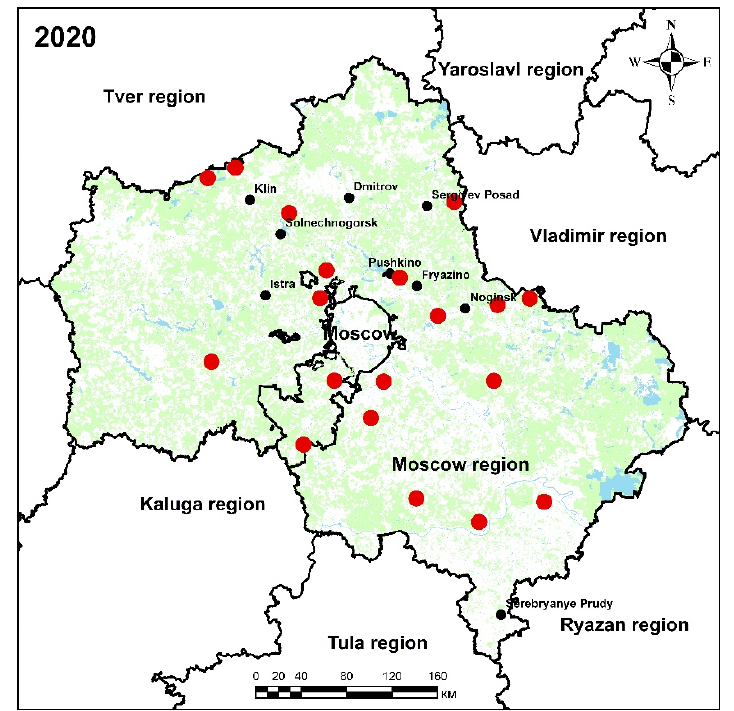
Figure 1. Sampling map (in 2019 and 2020 samples were collected in the same sampling sites) .